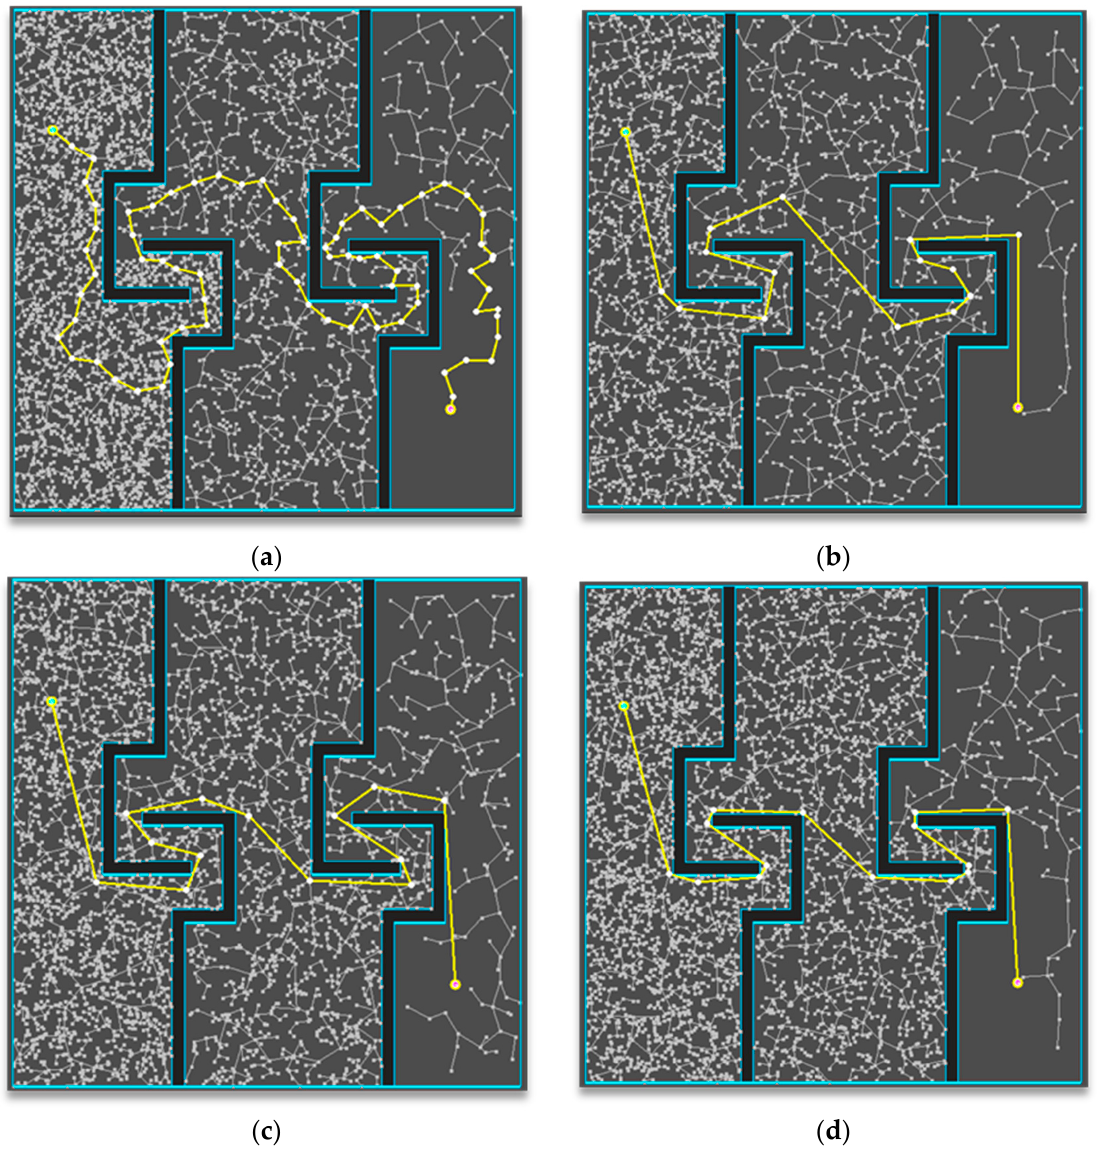
Figure 9. Experimental results of Map 1: ( a ) RRT; ( b ) proposed method ( ε : 50 px) applied; ( c ) proposed method ( ε : 30 px) applied; ( d ) proposed method ( ε : 10 px) applied.